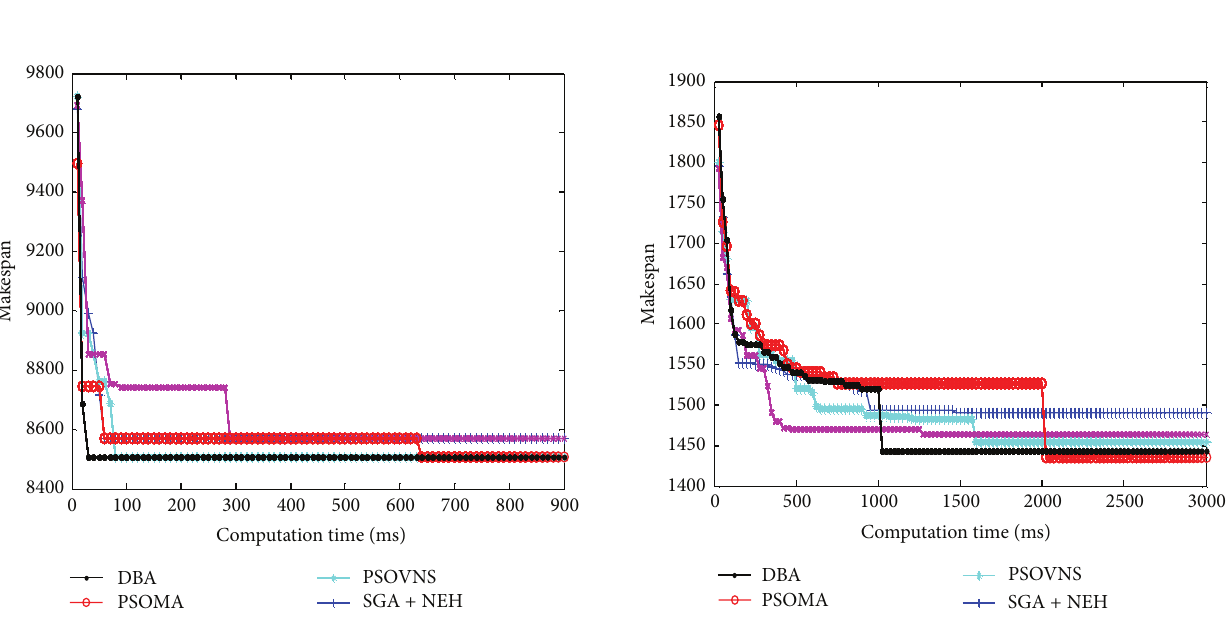
Figure 11: The convergence curves of Car6.